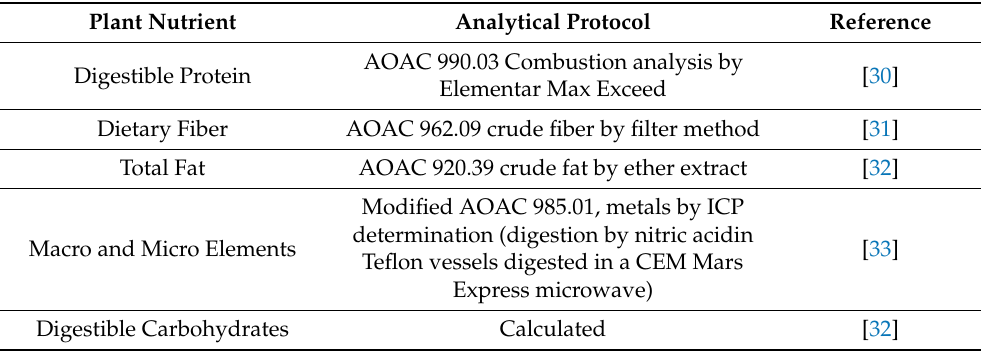
Table 3. Tigernut tuber analytical methods for digestible carbohydrates, digestible protein, dietary fiber, total fat, and elemental macro-and micro-nutrients (based on dry matter